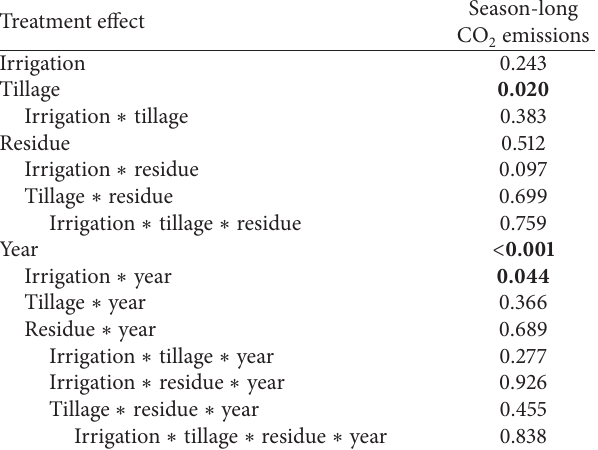
Table 1: Analysis of variance summary of the effects of irrigation, tillage, residue level (residue), year, and their interactions on esti- emissionsattheUniversityofArkansas’Lon matedseason-longCO 2 Mann Cotton Research Station near Marianna, AR, on a silt-loam soil. Interactions and main effects that are considered significant are indicated by bolded text ( 𝑃 < 0.05 ). This analysis ignores the burning treatment in the